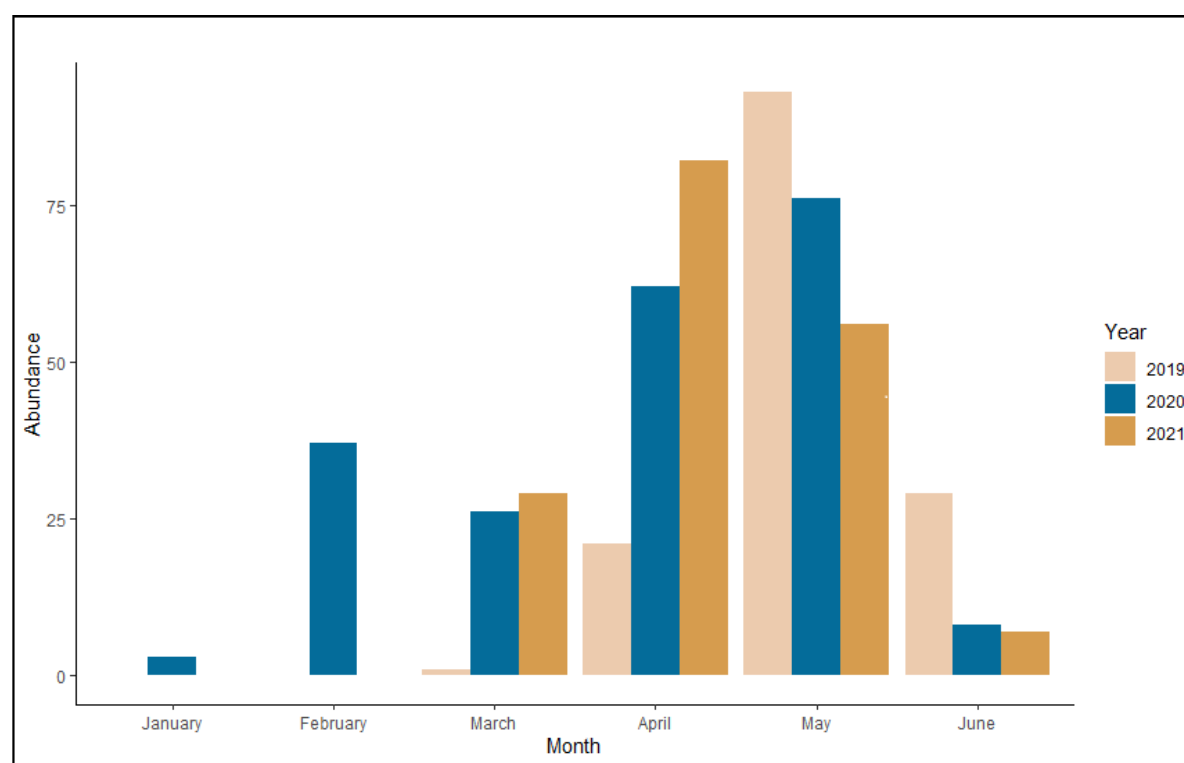
Figure 3. Histogram of the number of Rhithrogena sartorii specimens sampled each year in the study area (January 2019–June 2021).